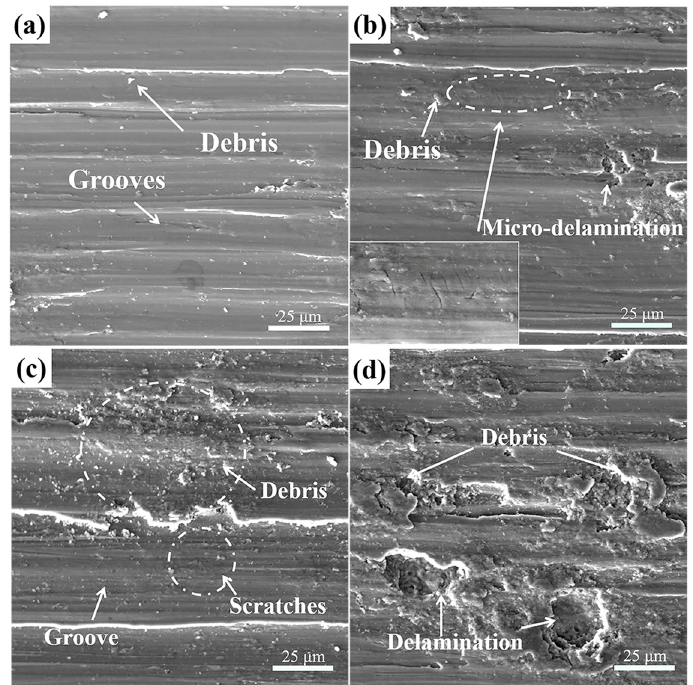
Figure 9. SEM images showing typical tribological features after different sliding time, observed on